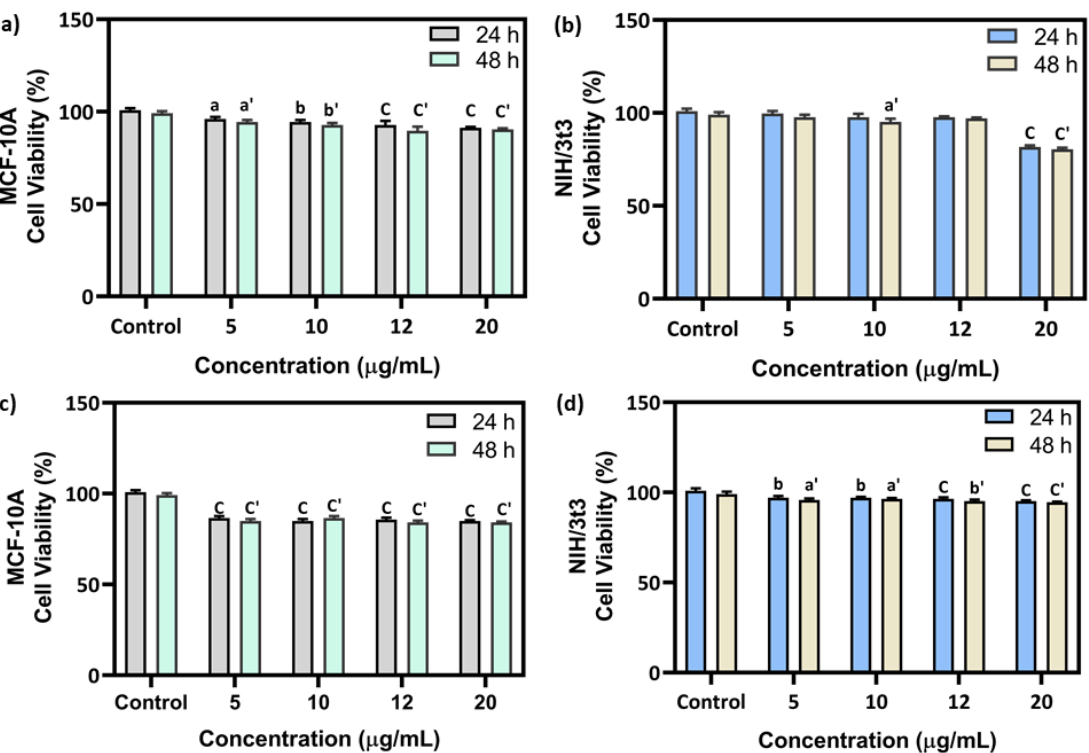
Figure 5. Cytotoxicity of ( a , b ) 3-MBTSc and ( c , d ) 4-NBTSc compounds on MCF-10A and NIH-3T3 cells. The toxicity was measured by MTT in a dose-dependent manner till 48 h. All the experiments were conducted three independent times and each treatment was kept in triplicates (n = 3). a, a’ = * p < 0.05; b, b’ = ** p < 0.01; c, c’ = *** p < 0.001.